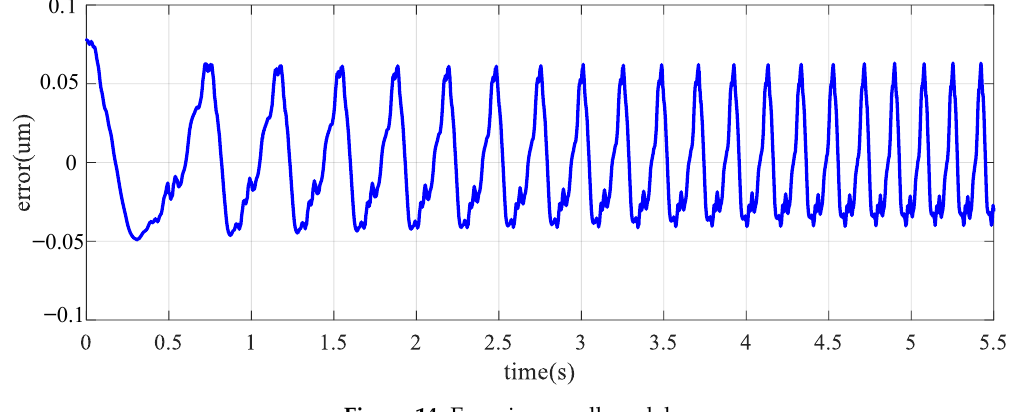
Figure 14. Error in overall